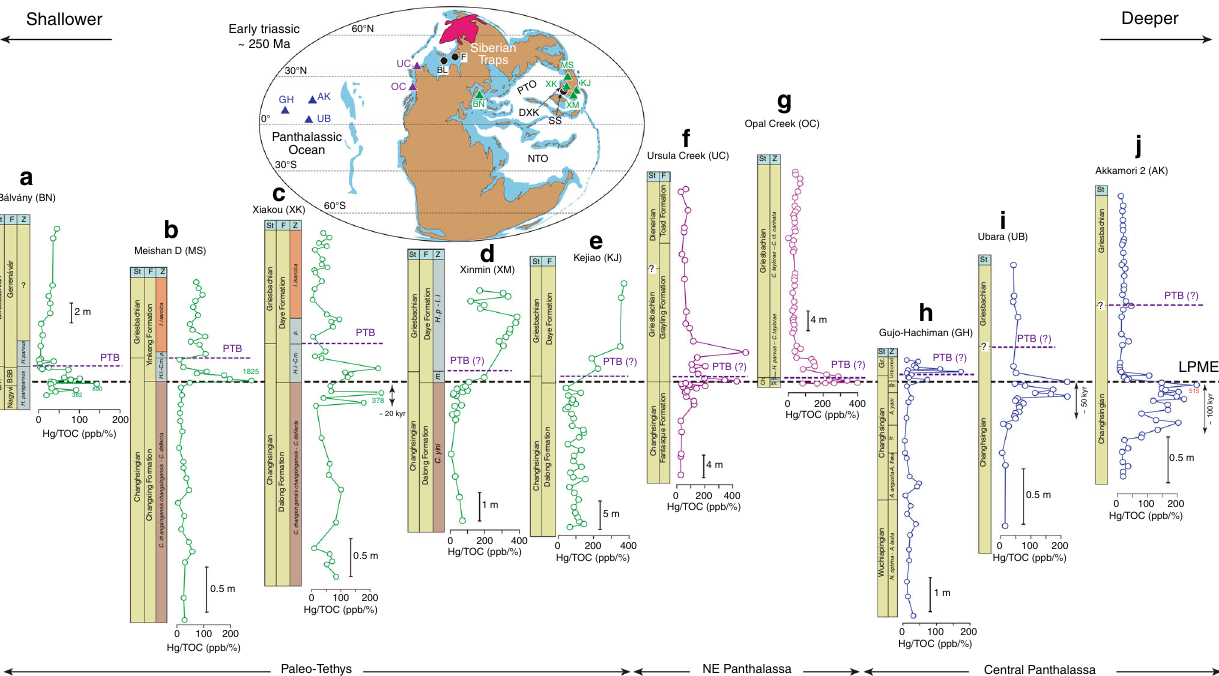
Fig. 1 Mercury concentration pro fi les (Hg/TOC) of study sections. a Bálvány, b Meishan D, c Xiakou, d Xinmin, e Kejiao, f Ursula Creek, g Opal Creek, h Gujo-Hachiman, i Ubara, and j Akkamori 2. The red vertical double-arrow lines in Xiakou, Ubara, and Akkamori-2 sections represent time gaps between the initial Hg spike and the LPME. Section locations shown on Early Triassic (~250 Ma) global paleogeographic map (adapted from Ron Blakey, http://jan.ucc. nau.edu/~rcb7/). Triangles represent the sections analyzed in this study (green, purple, and blue represent sections from Paleo-Tethys, Neo-Tethys, and Panthalassic oceans, respectively), and black circles show previously investigated sections in northern Laurentia and the South China area (see text). A . Albaillella ; C. Clarkina ; de . A. degradans ; H. Hindeodus; H.l.-C.m . H. latidentatus-C. meishanensis ; H.p-I.i = H. parvus-I. isarcica; I. = Isarcicella; m . = C. meishanensis ; N. Neoalbaillella ; p . H. parvus ; sh. Mesogondolella sheni ; tr . A. triangularis; yin. C. yini . Ch. Changhsingian, Gr. Griesbachian; St (sub)stage; F formation; B bed; Z conodont zone (all sections except Gujo-Hachiman), and radiolarian zone (Gujo-Hachiman). Sections: AK Akkamori-2; BL Buchanan Lake; BN Bálvány; DXK Daxiakou; F Festningen; GH Gujo-Hachiman; KJ Kejiao; M Mud; MS Meishan; OC Opal Creek; SS Shangsi; UB Ubara; UC Ursula Creek; XM Xinmin; XK Xiakou. BSB boundary shale beds, PTO Paleo-Tethys Ocean, NTO Neo-Tethys Ocean. LPME latest Permian mass extinction, PTB Permian – Triassic boundary. Note: full geochemical data are in Supplementary Figures 2 – 11. Source data are provided as a Source Data fi